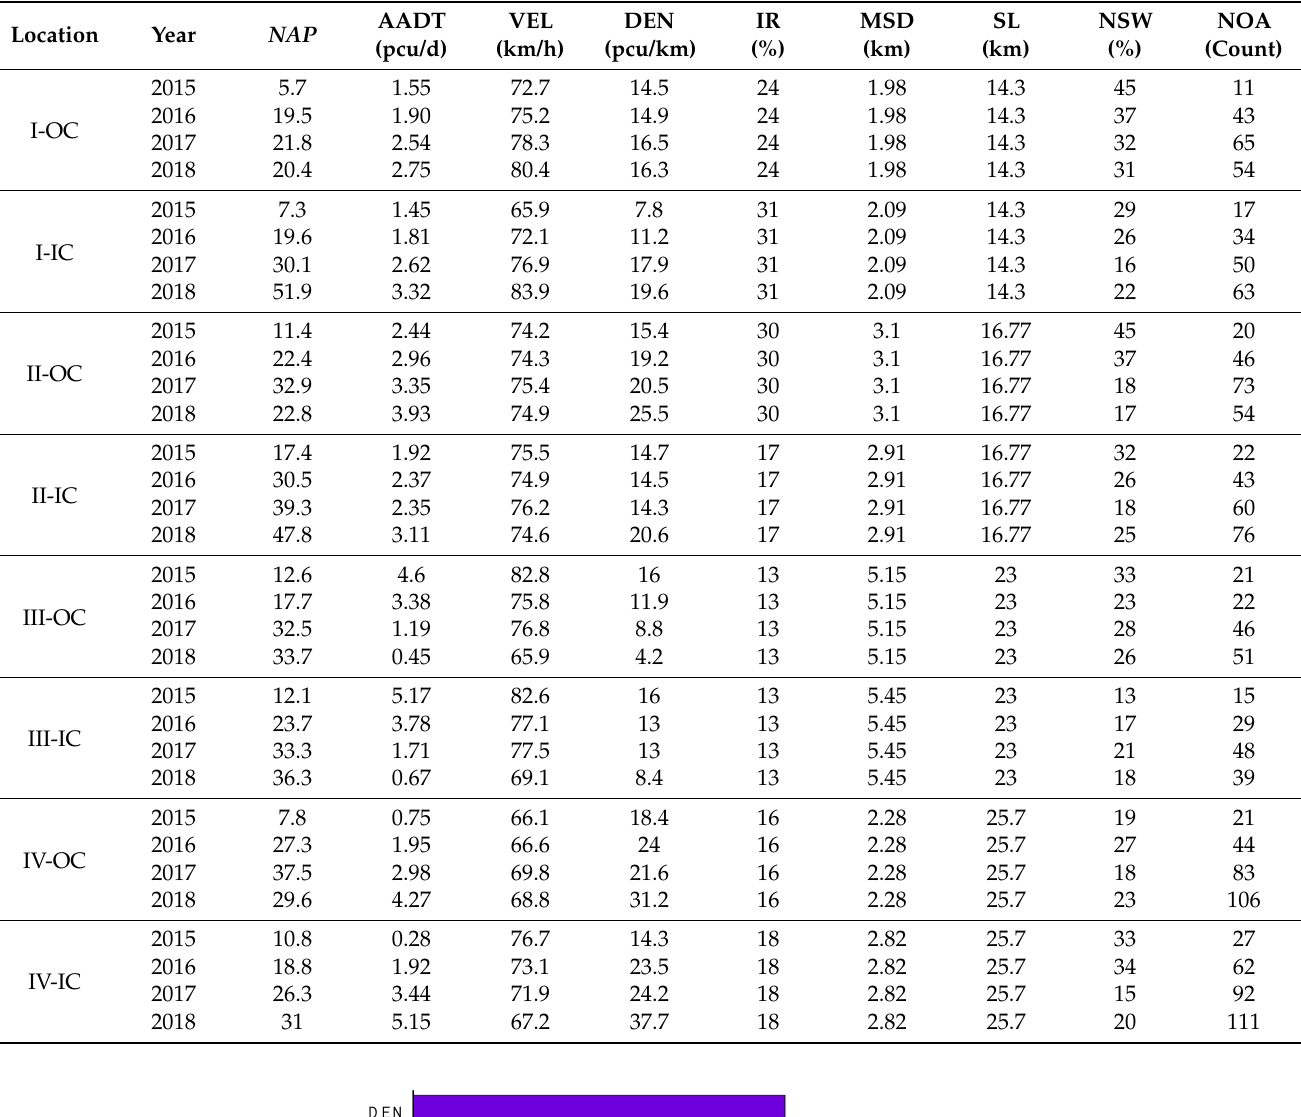
Table 2. The values of the independent variable and dependent variable.